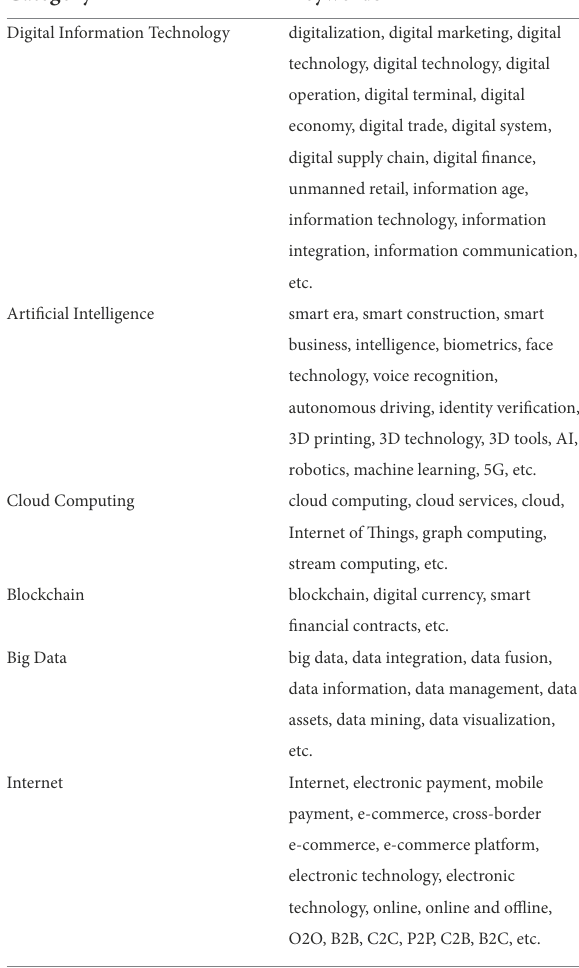
TABLE 1 Construction of “enterprise digitalization”